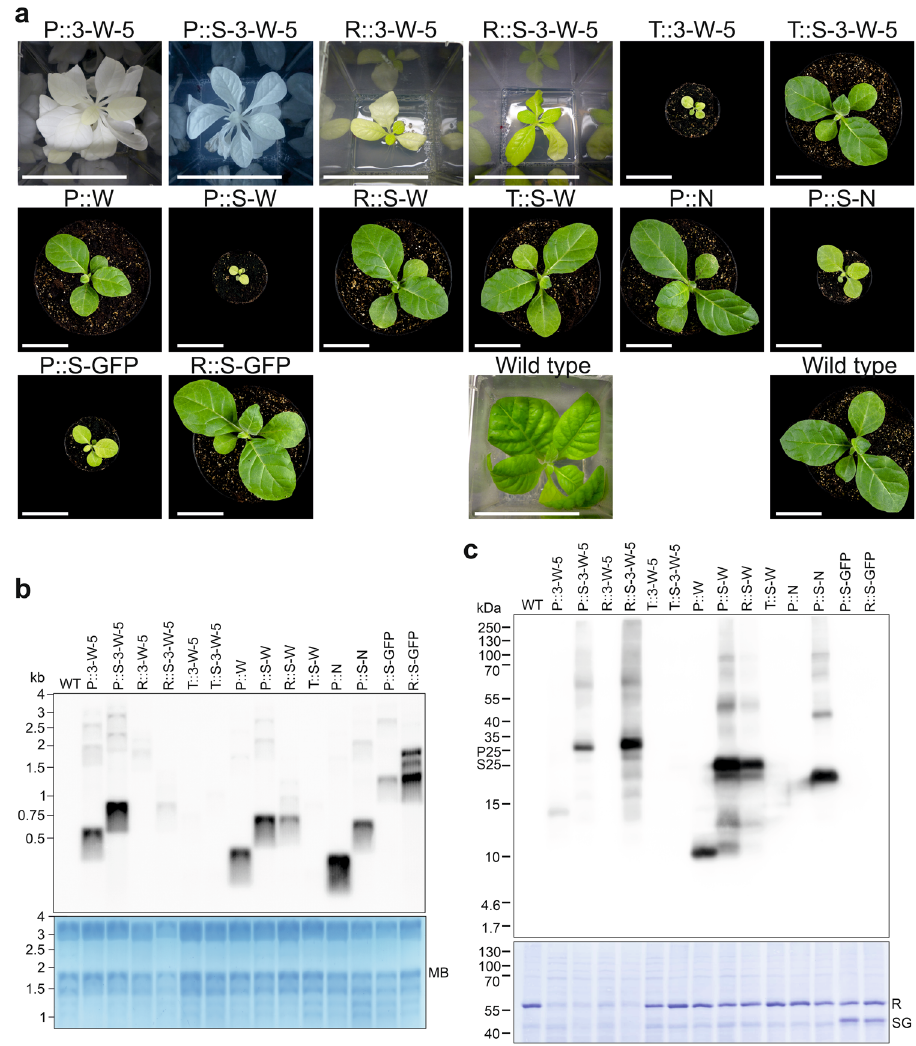
Fig. 6 | Comparison of transplastomic plants expressing AMPs and fAMPs either aloneorasfusions to SUMO(S)under thecontrolofdifferentpromoter systems. a Images of plants grown in sterile culture on synthetic medium. Photos weretakenthreeweeksaftertransferofstemcuttingsfromR::3-W-5andR::S-3-W-5, six months after transfer for P::3-W-5 (image from Fig. 2a), and three months after transfer for P::S-3-W-5. Photos of soil-grown plants were taken one month after sowing. Scale bars: 5cm. For images of soil-grown plants after two months, see Supplementary Fig. 4. b Northern blot analysis comparing mRNA accumulation levelsin the different transplastomic lines shown in (a) (seeMethods section). MB: methylene blue staining (as loading control). This blot was performed twice with similar results. c Western blot analysis comparing the effects of SUMO fusion on protein accumulation in the different transplastomic lines. Samples of 20 µ g total leaf protein were separated by gel electrophoresis, blotted and immunodetection